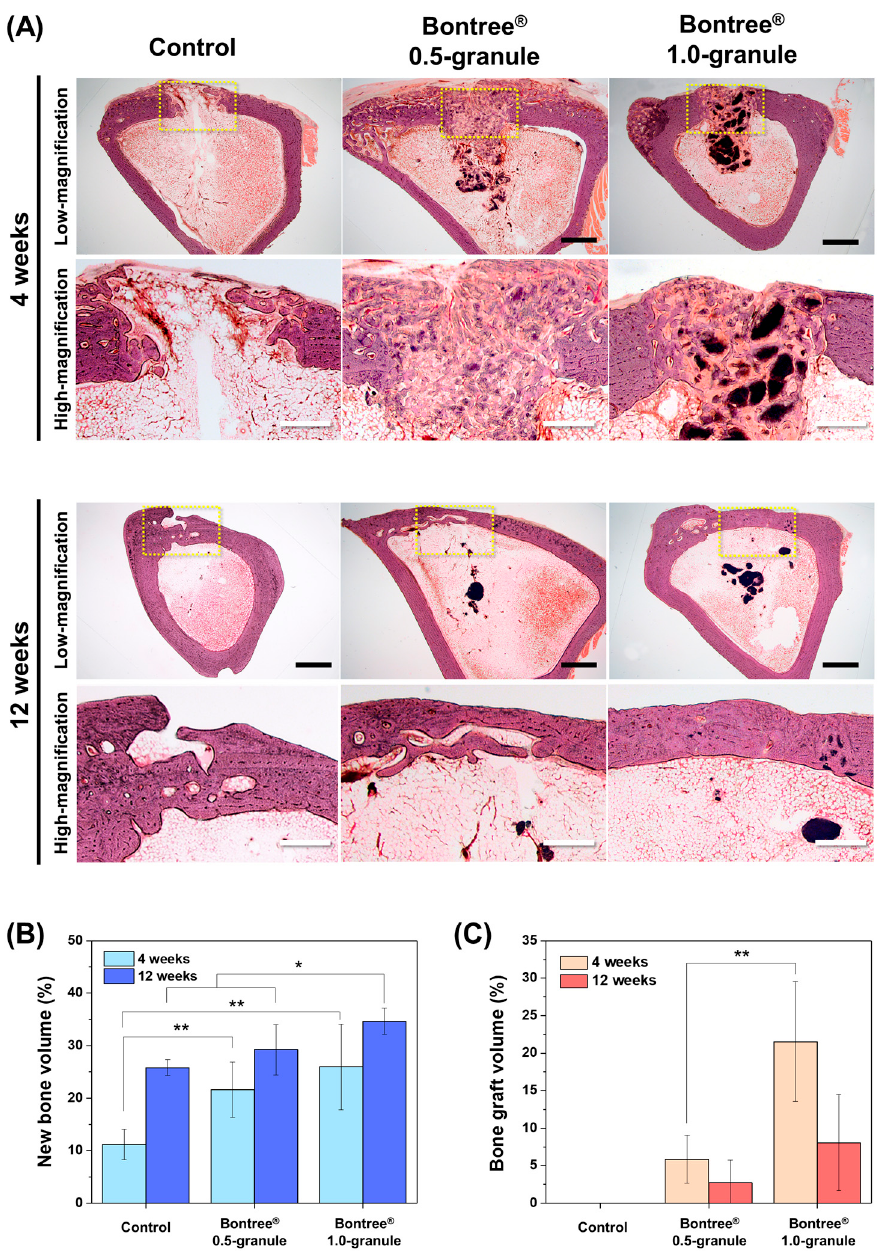
Figure 3. ( A ) Representative histological images with low- and high-magnifications of the bone graft implantation regions in a rabbit tibia 4 and 12 weeks after surgery. Magnified regions are marked with yellow rectangles in the low magnification images. Black and white bars indicate 2 mm and 1 mm, respectively. Percentages of ( B ) new bone and ( C ) bone graft volumes compared with the tibial defect volume at 4 and 12 weeks after surgery. Statistical significance was set at * p < 0.05 and ** p < 0.01, respectively.